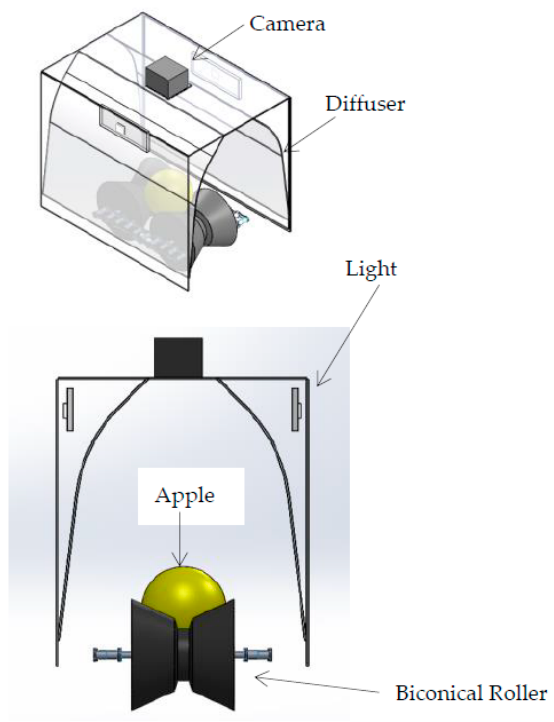
Figure 1. Schematic of light sources arrangement in the locally designed imaging chamber (perspec- tive and front view).